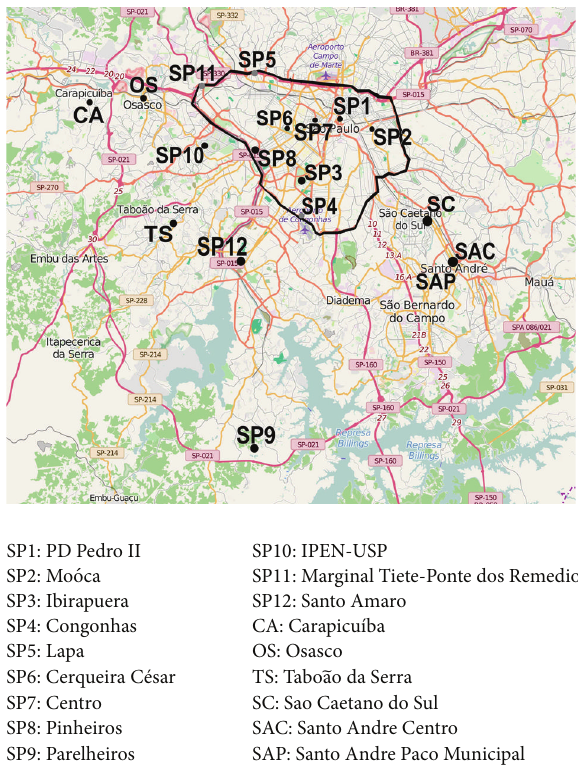
Figure 1: Spatial distribution of the monitoring stations in the MRSP. Each marker represents a station that has recorded CO concentration between 1996 and 2013. Black thick line represents the traffic restriction area for light-duty vehicles. SAC and SAP stations are very close and are represented by the same marker. SAP has substituted SAC station (source: OpenStreetMap, 06 Jul